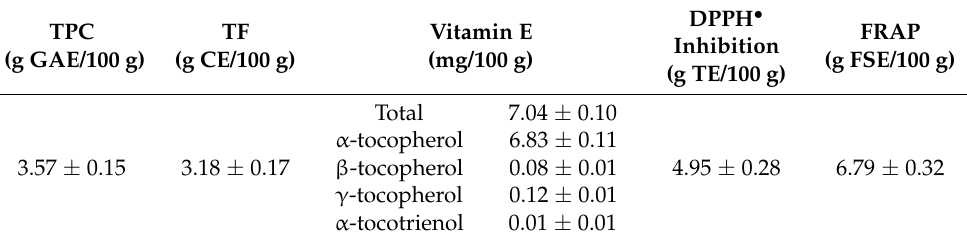
Table 3. Phytochemical analysis, vitamin E content, and antioxidant activity of the semi-solid paste (SSP) obtained from the fresh olive pomace.